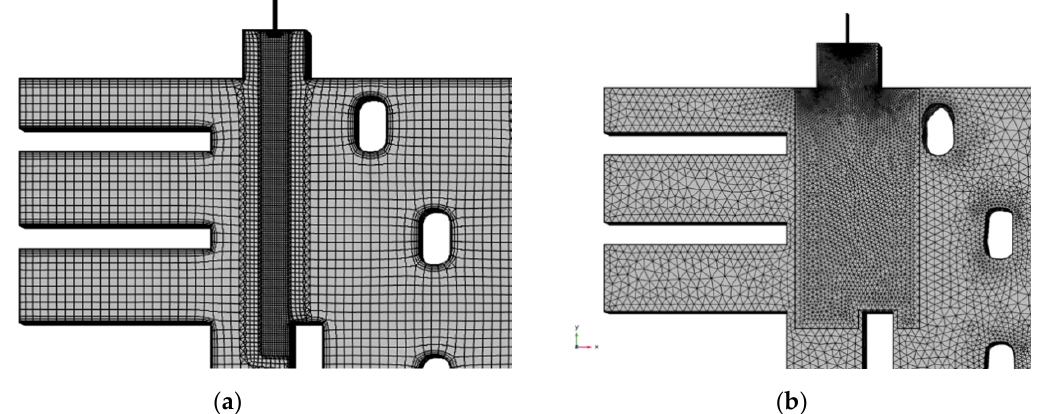
Figure 4. Magnification at one of the combustion zones (the leftmost top zone) of meshes: ( a ) mesh 2; ( b ) mesh 3. Table 4. Skewness quality measure values.